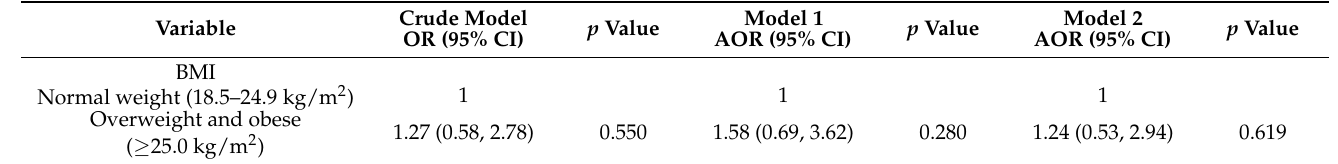
Table 4. Odds ratios (95% confidence interval) of associations between low dietary diversity and nutritional status and cardiometabolic risk